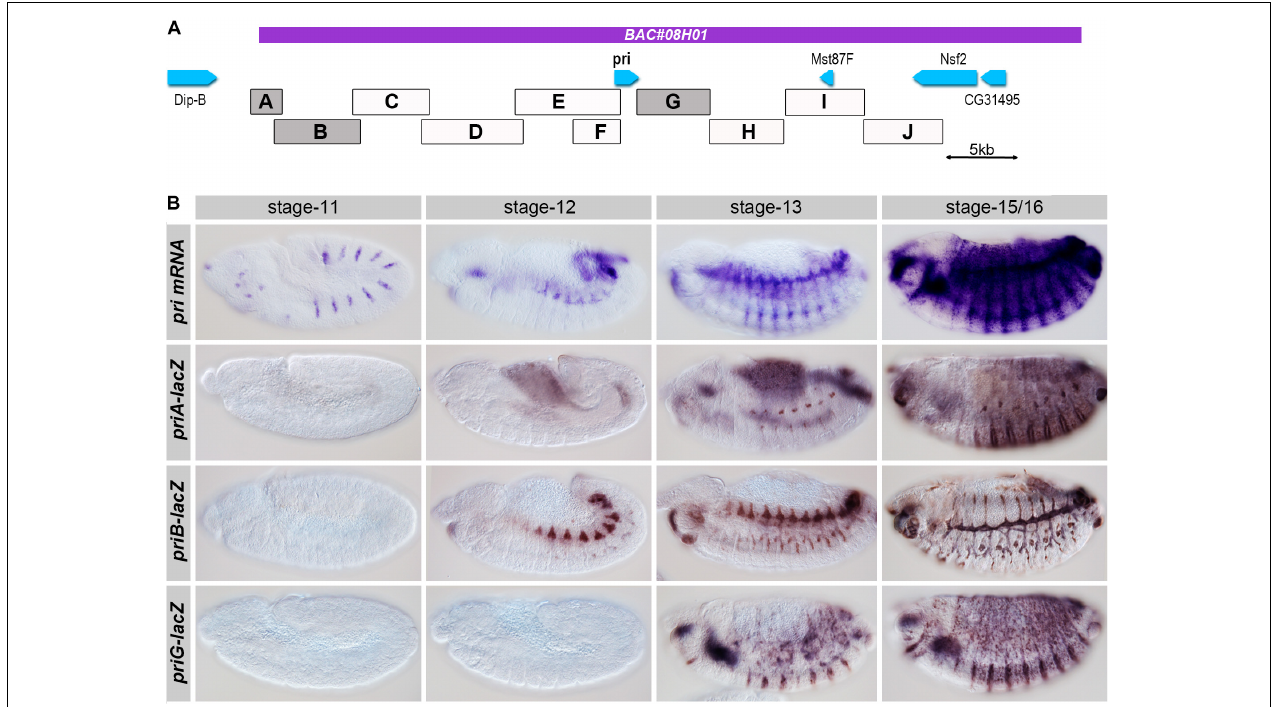
FIGURE 3 | Functional identification of pri embryonic enhancers. (A) Boxes represent the genomic location of the regions tested using lacZ-reporter transgenic lines; the boxes highlighted in gray showed a significant activity during embryogenesis, and the purple line shows the region carried by BAC08H01 that restores significant adult viability. (B) Time course of pri mRNA expression from mid to late embryogenesis, as revealed by in situ hybridization (top). Expression driven by the three main embryonic enhancers ( priA , priB , and priG ) at corresponding stages of development was revealed by anti-ß-Gal